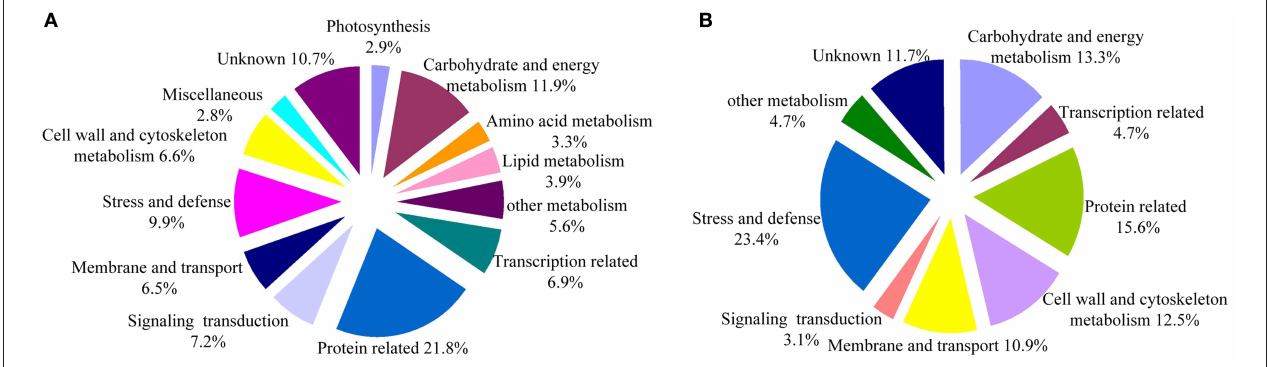
FIGURE 3 | Functional classification of the identified proteins. (A) All 1649 proteins. (B) Differentially expressed proteins in salt stress cotton roots as compared to the control. The percentage for each class is shown and represented in the pie-chart.